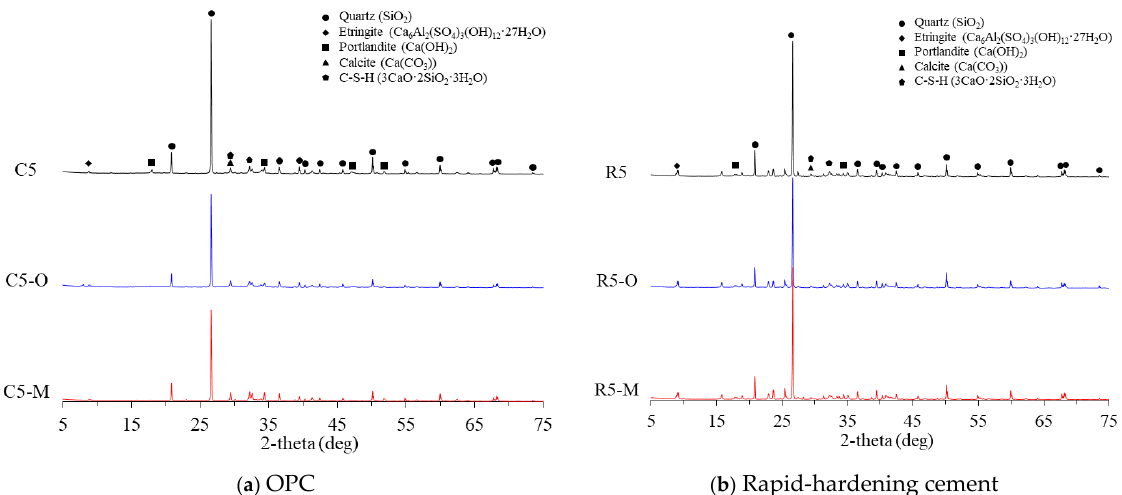
Figure 3. XRD results of cement mortar mixed with water repellents.